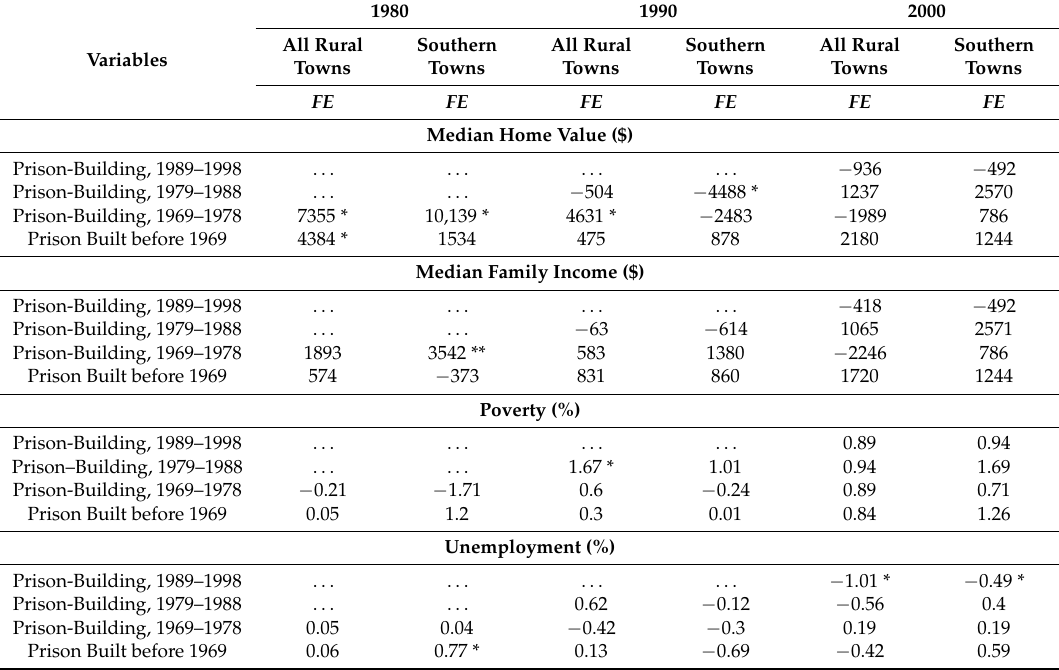
Table 4. State-level fixed-effects estimates of rural property value, family income, poverty, and unemployment as a function of recent prison-building from 1980 to